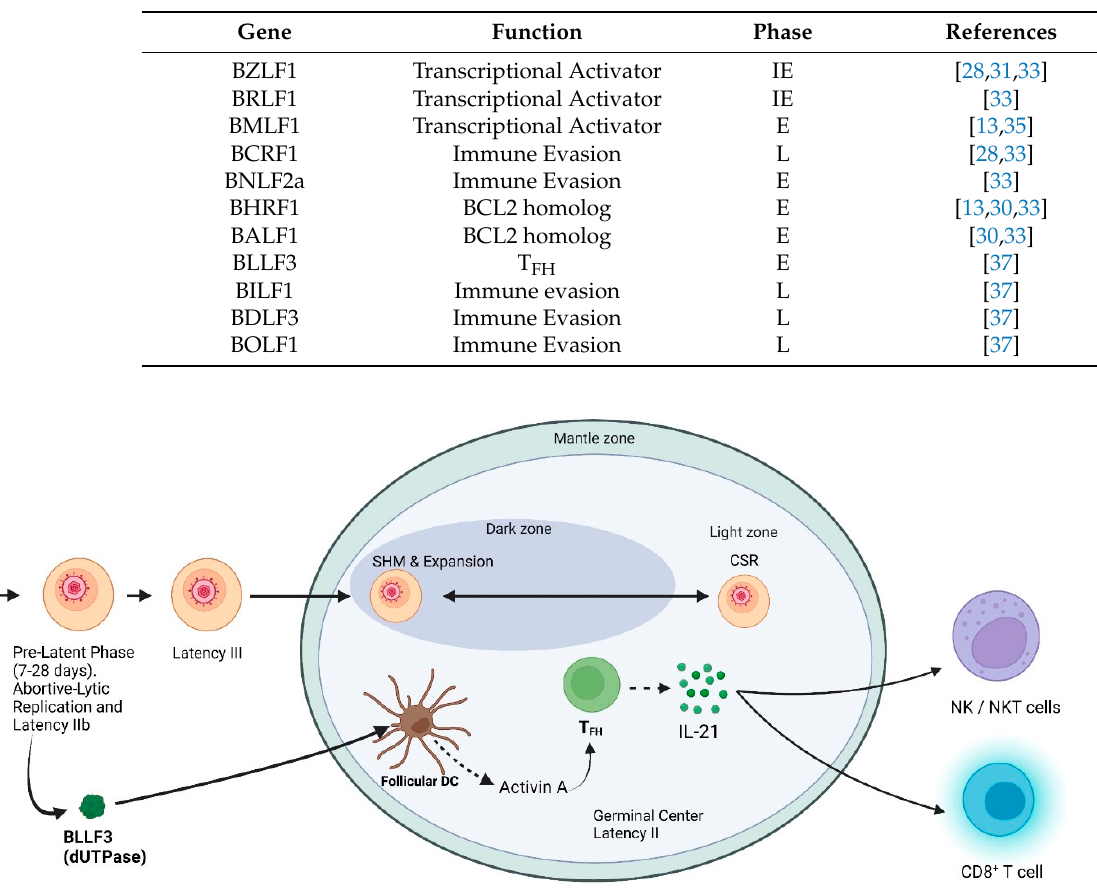
Table 1. Lytic EBV Genes Expressed During the Pre-Latent Phase.